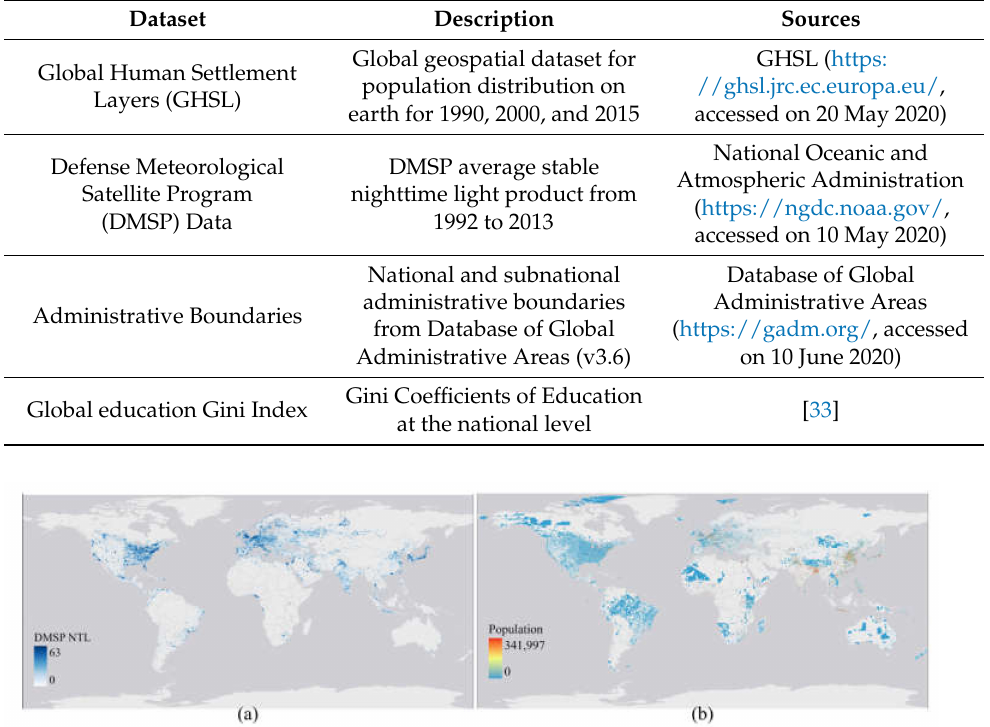
Table 1. Datasets for calculating the Nighttime Light Development Index (NLDI) and urbaniza- tion Gini.